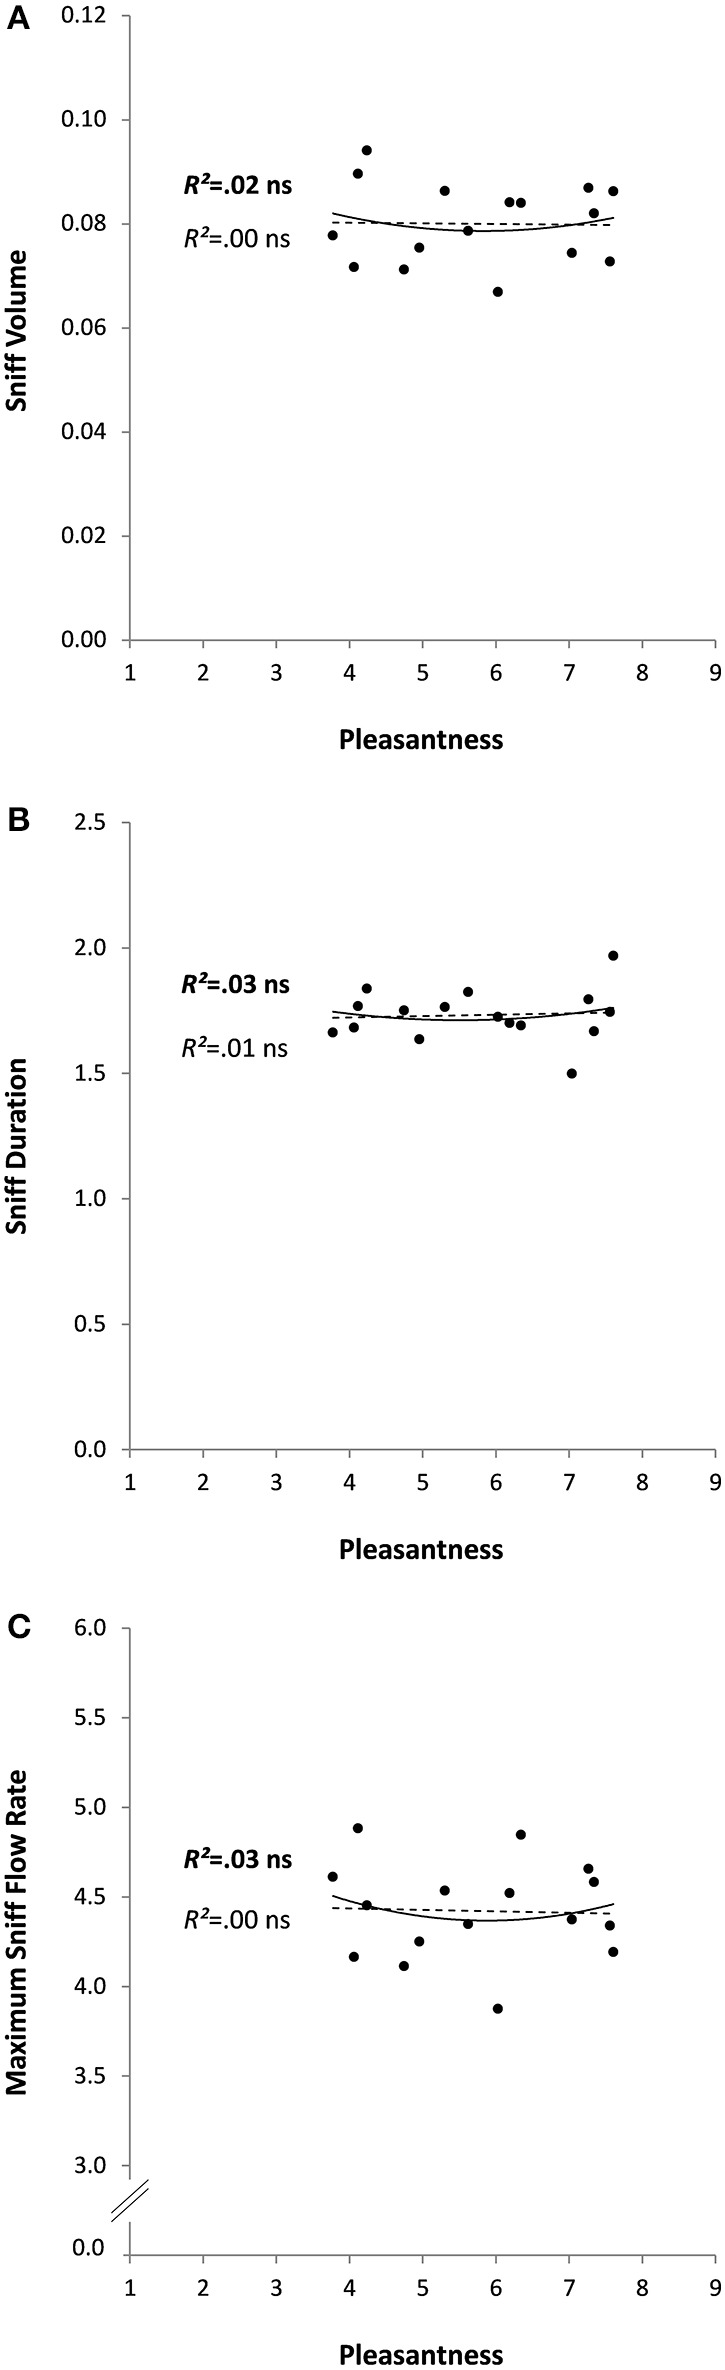
Sniff characteristics (A: volume, B: duration, and C: maximum flow rate) as a function of odor pleasantness for 16 odorants in Experiment 2. Linear and quadratic relationships are represented by trend curves, R2 and level of significance (ns: non-significant or p > 0.05; linear: dashed line and regular font; quadratic: continuous line and bold font).